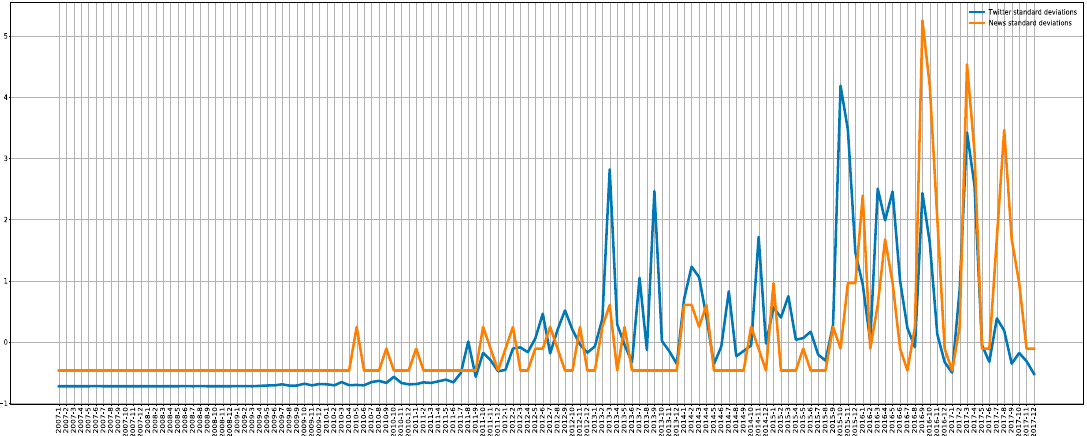
Figure 5. Detrended normalized monthly number of tweets and monthly number of online news on rhino trade.